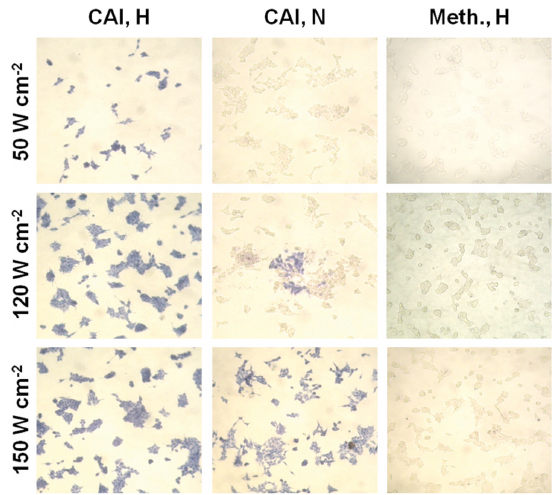
Figure 4. 470 μm × 400 μm Optical micrographs of HCT cells treated with 100 μM Au particles 16, 17 with different terminations and under hypoxia (H) or normoxia (N), and then excited with light at 810 nm and different power density for 5 min. After fixation, cells were stained with trypan blue [21].